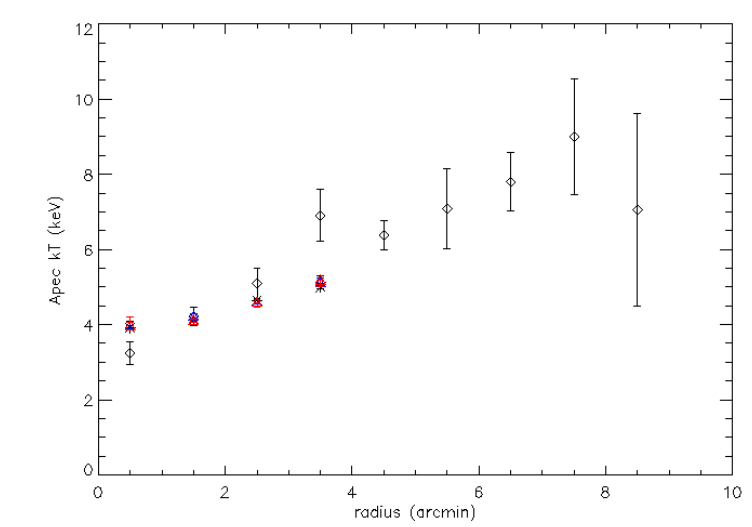
Figure 4. Cluster temperature as a function of average radius of annular region for spectral fit with tbabs(apec+powerlaw). Results obtained from fitting only XRT (marked by diamonds), NuSTAR (triangles) and combined XRT- NuSTAR spectrum (asterisks) are shown for data collected on 3 November 2015. Results from NuSTAR fit for 2017 February 1 and 4 data are shown in blue and red colours,